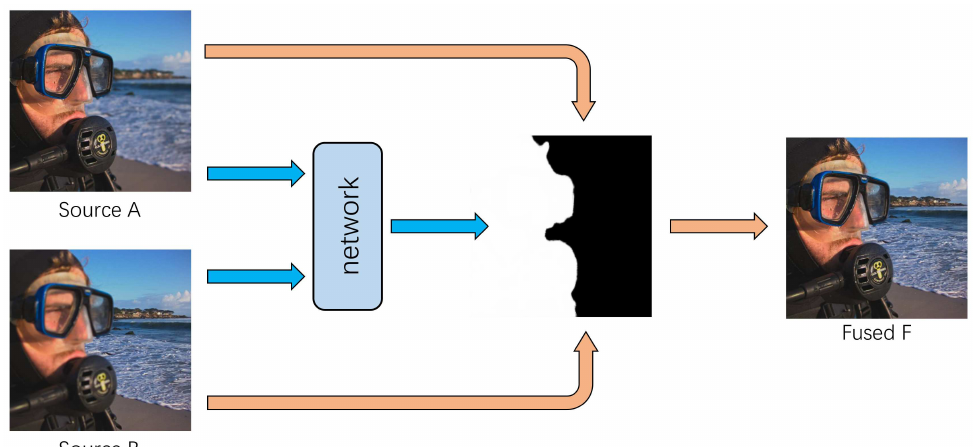
Figure 2. The schematic diagram of the proposed method. Source A and Source B are input into the network to get a decision map that can be used to guide image